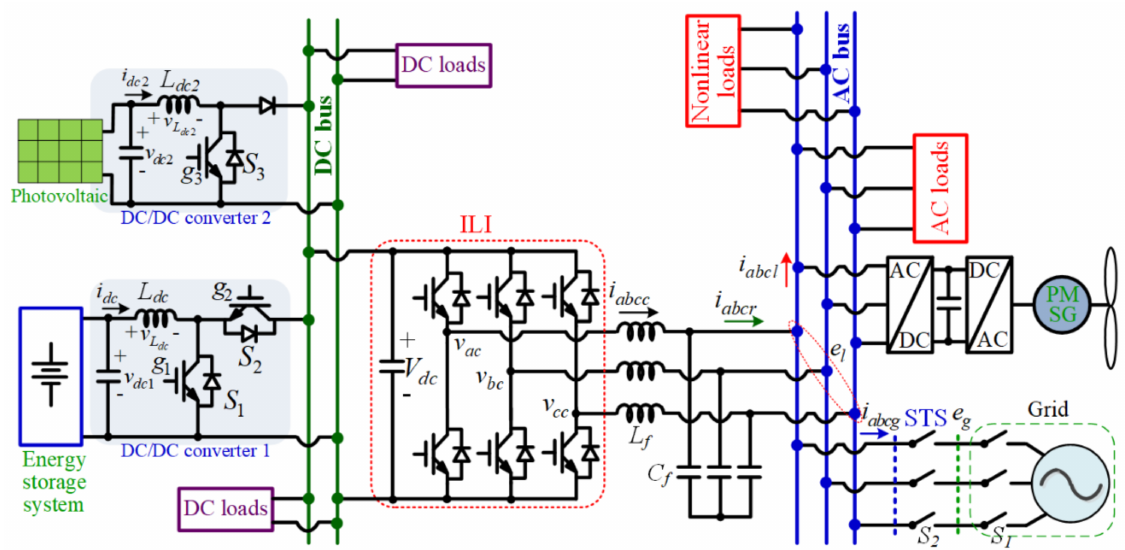
Figure 1. Schematic diagram of hybrid AC/DC